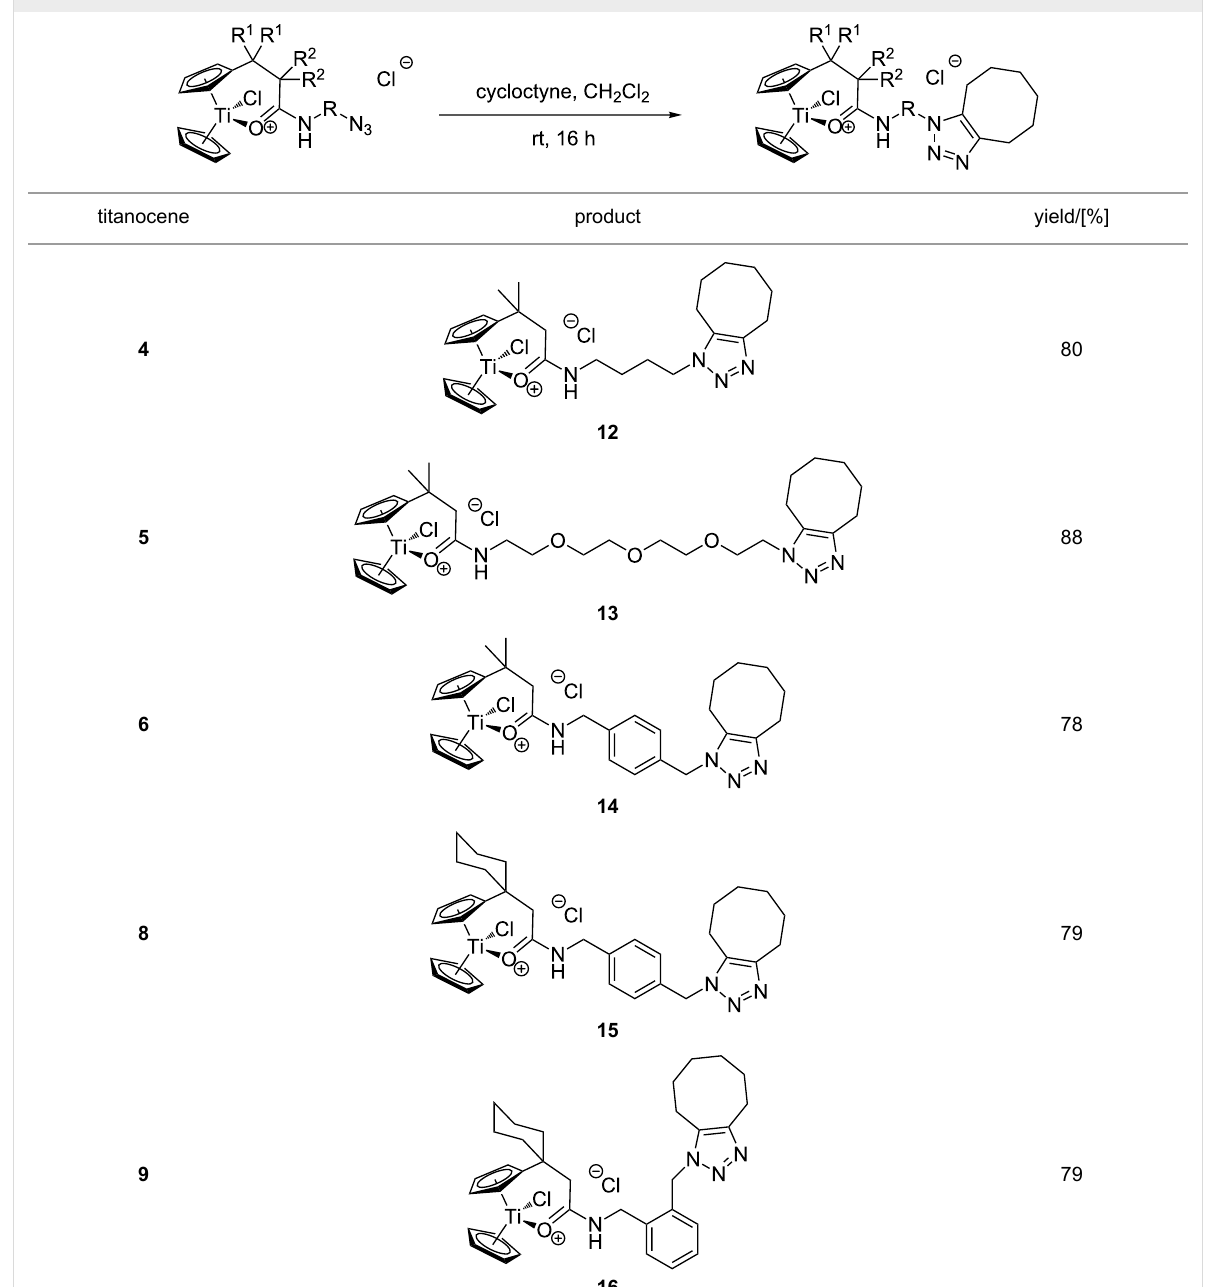
Table 2: Strain-driven 1,3-dipolar cycloadditions between cyclooctyne and azide-functionalized titanocenes in CH 2 Cl 2 (0.1 M).